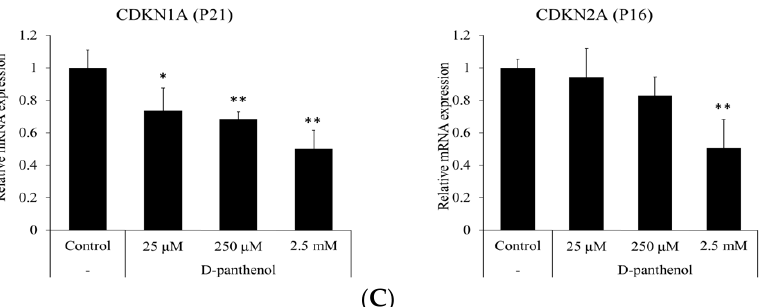
Figure 6. D-panthenol stimulated the growth of human outer root sheath cells (hORSCs). ( A ) The growth of hORSCs was assessed after 24 h treatment of D-panthenol. ( B ) Relative mRNA expression ratios of Bcl2 to Bax were calculated after 24 h treatment of D-panthenol. ( C ) mRNA expression of senescence markers (p21 and p16) in cultured hORSCs after 24 h treatment of D-panthenol. * p < 0.05, ** p < 0.01 versus control group. Data are expressed as mean ± SD.